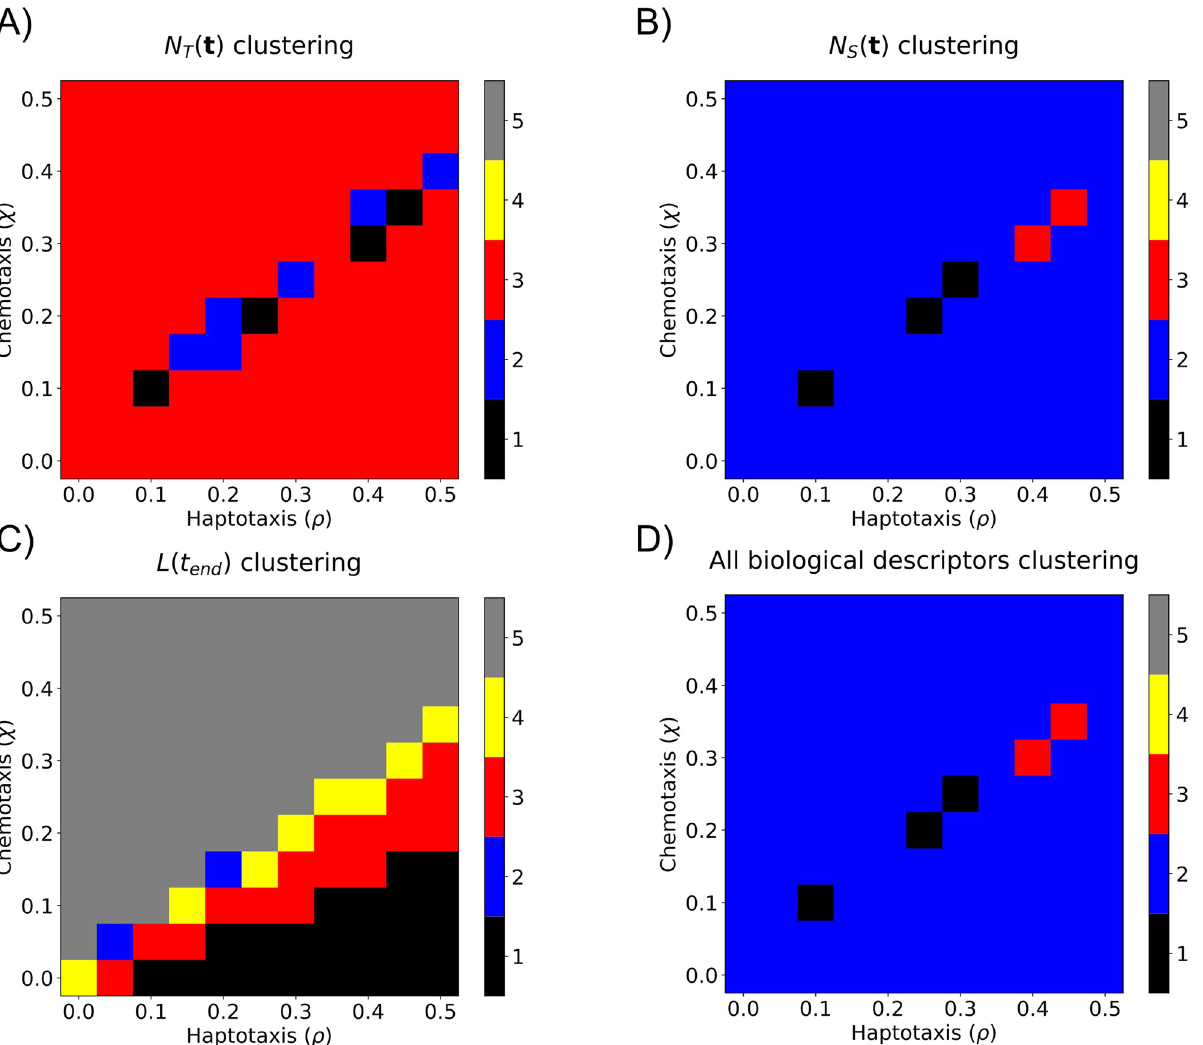
Fig 12. Partitioning ( ρ , χ ) parameter space into distinct regions using standard biological descriptor vectors. We applied k -means clustering, with k = 5, to standard biological descriptor vectors. The resulting partitions are presented for A) N T ( t ), B) N S ( t ), C) L ( t end ), and D) concatenation of all three descriptor vectors. The five clusters are ordered according to the mean χ value within the